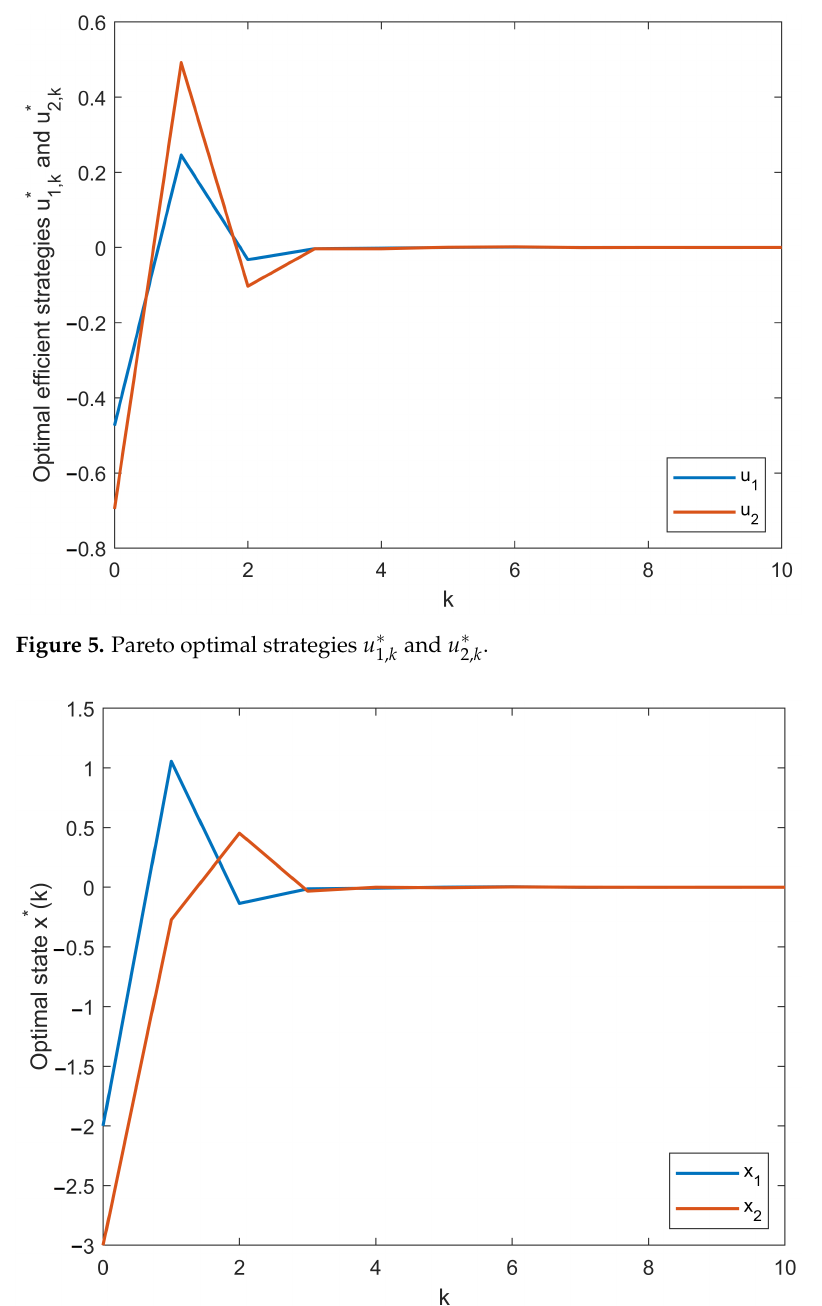
Figure 6. Optimal state x ∗